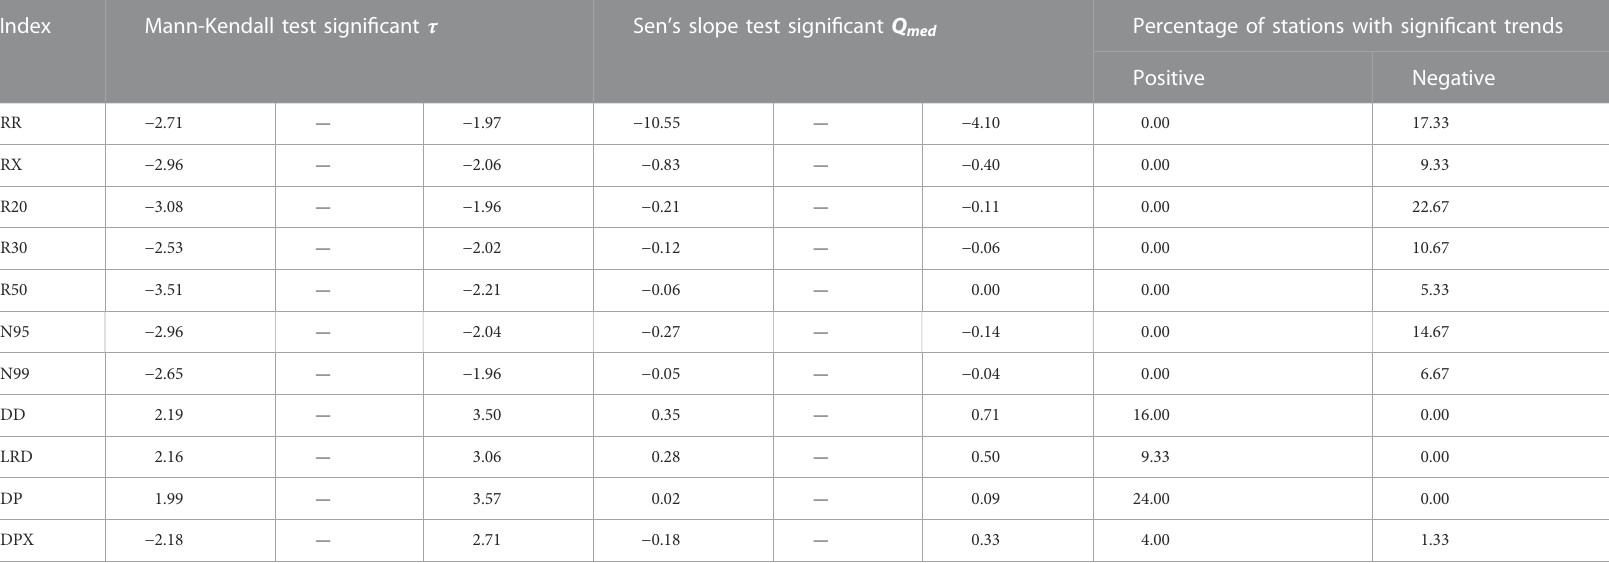
TABLE 3 Mann-Kendall ( τ ) and Sen ’ s slope estimator ( Q med ) tests results at the 5% signi fi cant level and the percentage of stations with signi fi cant trends for the precipitation indices in the rainy season from 1974 to